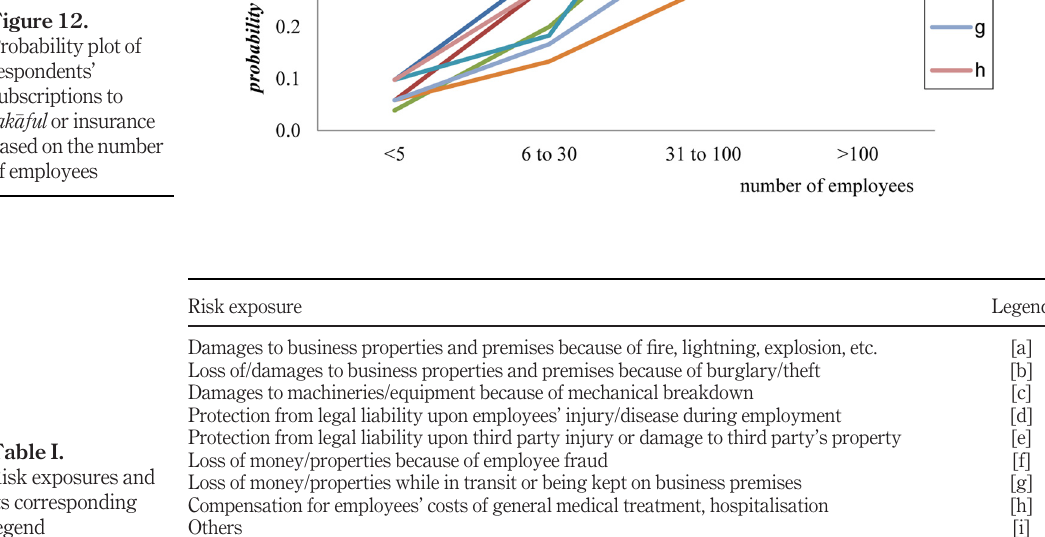
Figure 12. Probability plot of respondents ’